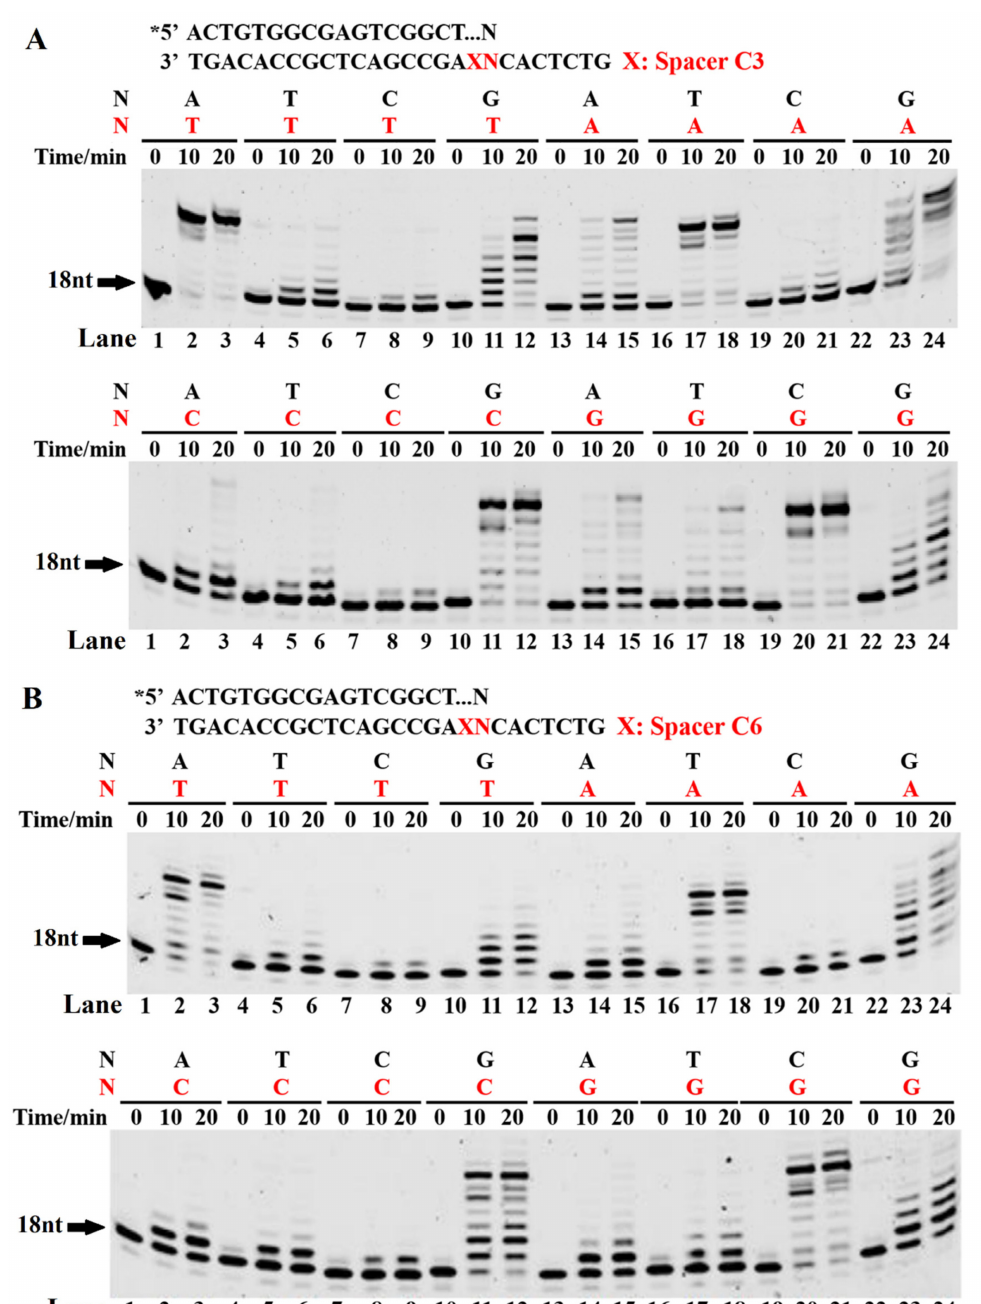
Figure 1. Primer extension of paired or mispaired 3 (cid:48) base pairs with a bulging spacer. The PT DNA substrates are shown at the top of the figure, where the letter X denotes spacers C3 ( A ) and C6 ( B ). The first 3 (cid:48) base of the primer strand is A, T, C, or G. The first base upstream of the AP site in the template strand is A, T, C, or G. Four primer strands were annealed with four different template strands to form 16 kinds of PT DNA substrates with a bulging spacer C3 or C6, which were incubated with 0.5 µ M Dbh and dNTPs at 45 ◦ C for 0, 10, 20, and 60 min. Asterisks denote the terminal fluorescent group